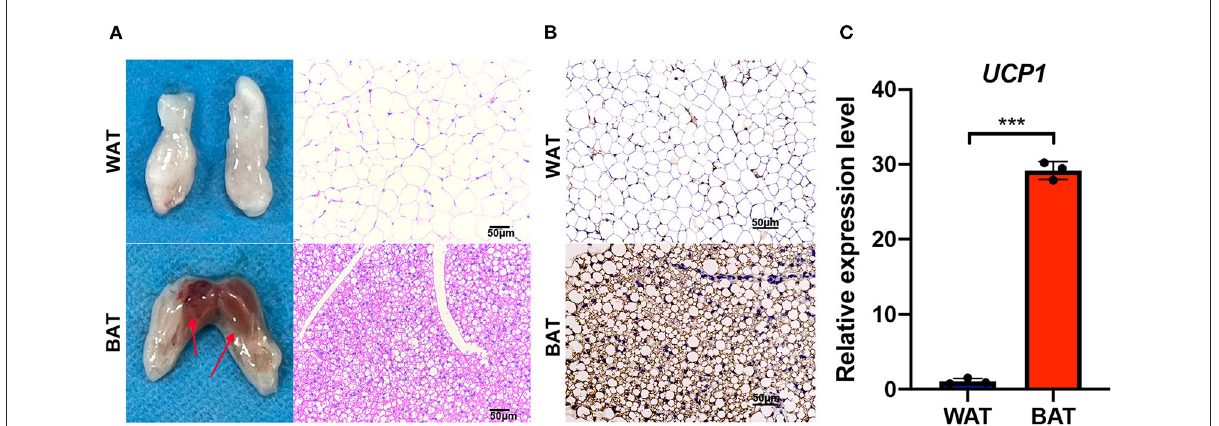
FIGURE1 Phenotypic characterization of brown fat. (A) The abdominal white fat (up) and brown fat depots (down) were isolated. The right side shows the hematoxylin and eosin (HE) staining of corresponding adipose tissue, and the arrow points to the selected sample position during sequencing.